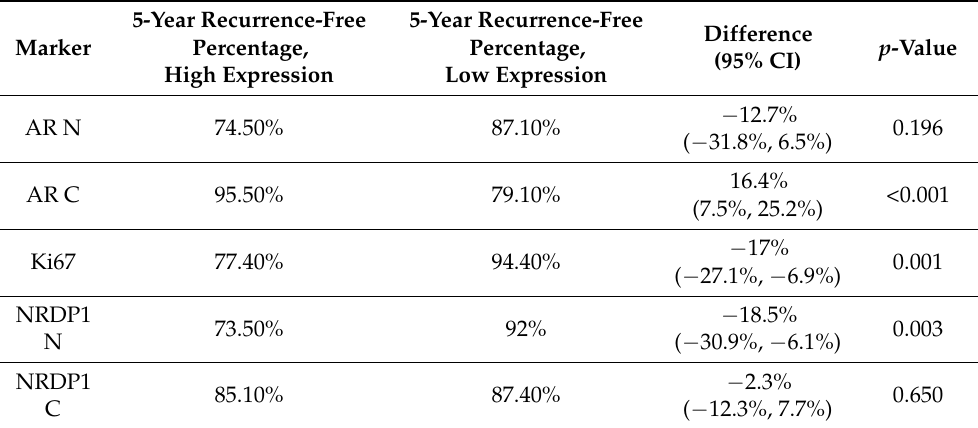
Table 3. Recurrence Free Percentages at Five Years by Marker Expression.